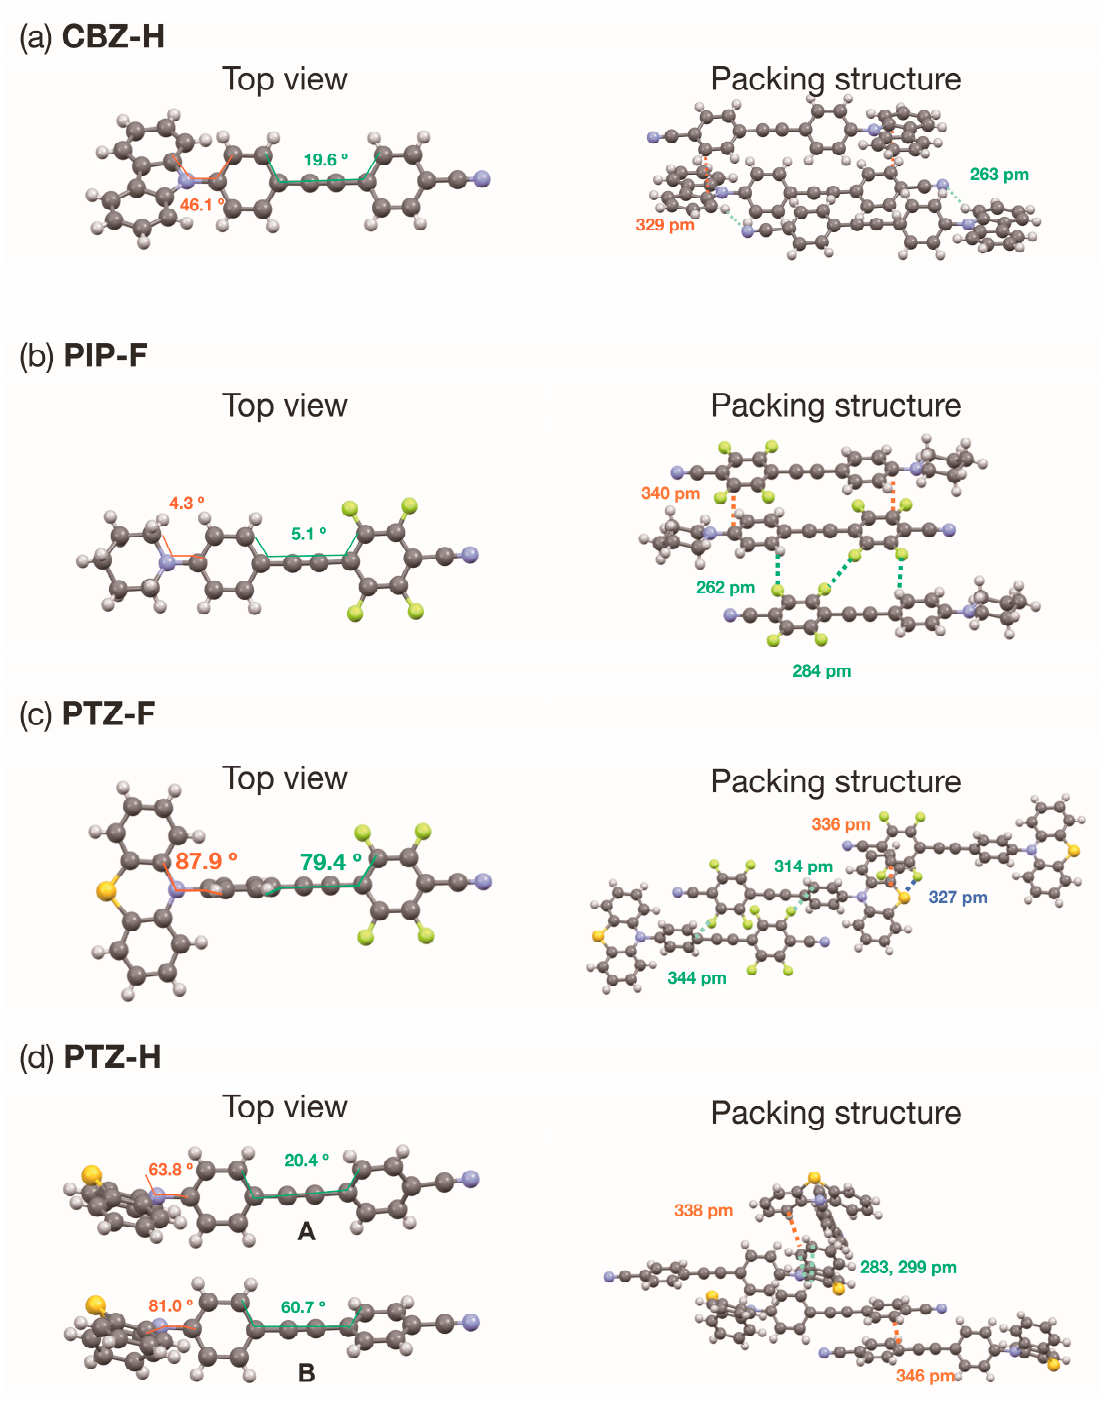
Figure 6. Crystal structure from top view, and the packing structures with interatomic short-contacts for ( a ) CBZ-H , ( b ) PIP-F , ( c ) PTZ-F , and ( d ) PTZ-H . PTZ-H forms crystal structures in the triclinic P –1 space group, and the unit cell contains four molecular units. In contrast to CBZ- H , PIP-F , and PTZ-F , PTZ-H exhibited two conformational structures: one of the two aromatic rings in the tolane scaffold of conformer A possessed a twisted structure of 20.4 ◦ , whereas conformer B was twisted at 60.7 ◦ . In both conformers, the phenothiazine unit was twisted at 63.8 ◦ for A and 81.0 ◦ for B with respect to the aromatic ring in the tolane scaffold (Figure 6d). As shown in Figure 5d, the more twisted B intermolecularly formed loose π / π stacking with a short contact of